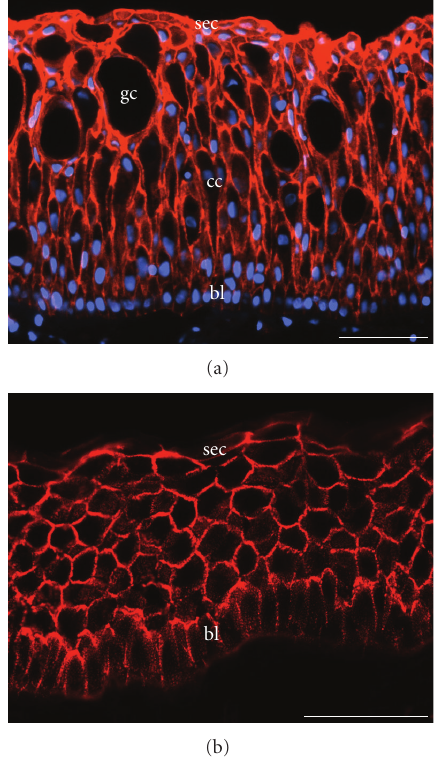
Figure 2: Immunofluorescence microscopy of cryostat sections through fish and amphibian skin, showing the localization of desmosomal components in all layers of the epidermis. (a) Immunofluorescence labeling of plakoglobin (red), in addition to nuclear DAPI staining (blue), in a section through the para ffi n- embedded skin of an eel ( Anguilla anguilla ). The section is shown after antigen retrieval and immunoreaction (for methods see [8]) using a monoclonal mouse plakoglobin antibody (mAb PG 5.1; Progen Biotechnik, Heidelberg, Germany). Note the distinct basal layer ( stratum basale ) of the epidermis and the relatively large club shaped cells (“club cells”) as well as the mucous goblet cells and the dense-packed apical cell layers. (b) Immunofluorescence labeling of desmoplakin on a cryostat section through the skin of the frog, Rana pipiens , using mAb DP447 (Progen Biotechnik). Note the continuous pattern of very closely spaced, finely punctate staining of the epidermal desmosomes. Bl: basal layer; cc: club cells; gc: goblet cells; sec: superficial epithelial cells (for histological terminology see [8]). Bar in (a): 100 μ m; bar in (b): 50 μ